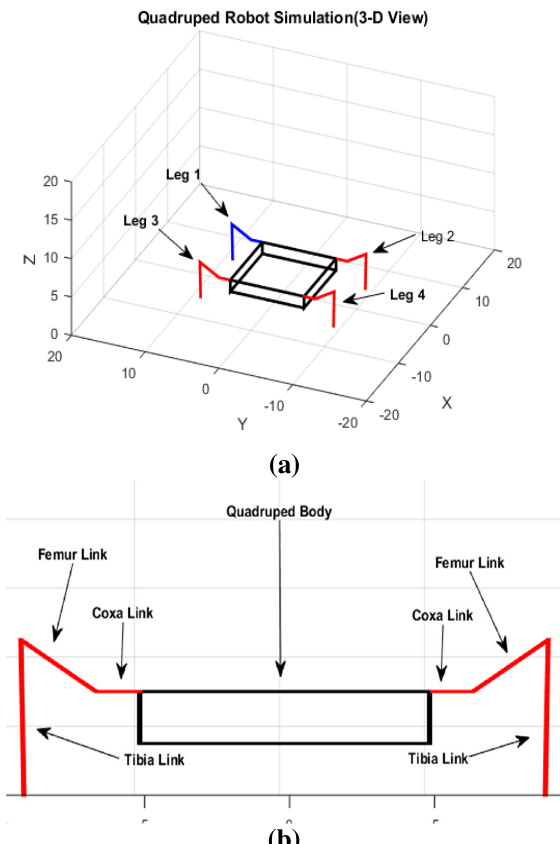
Fig. 2. Quadruped Robot Simulation Using Matlab (a) quadruped robot with four legs labeling (b) showing the three joints (Coxa, Femur, Tibia) in each